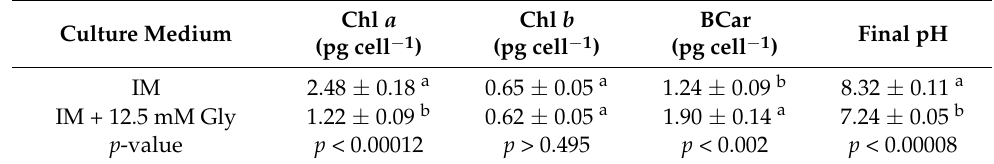
Figure 1. Cell density of D . salina cultured with different concentrations of glycerol (Gly). Salinity and light intensity were 1.5 M NaCl and 50 µ mol photons m − 2 s − 1 , respectively. Values correspond to the mean ± standard deviation of three replicates. Table 1. Chl a , Chl b , BCar, and culture pH of D . salina grown under 12.5 mM Gly and photoauto- trophic control. Efficient salinity for growth and light intensity were 1.5 M NaCl and 50 μ mol pho- tons m − 2 s − 1 , respectively. Values in the same column with different superscript are significantly different.